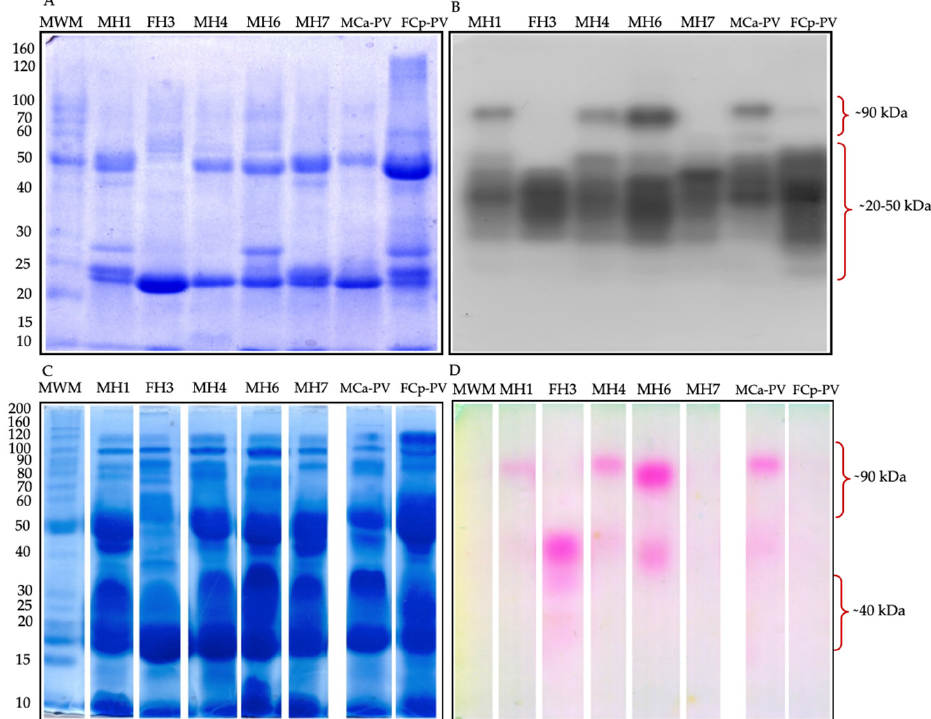
Figure 3. Venom serine protease-like zymography. ( A ) 50 µg of venom protein in a 10% SDS-PAGE gel. ( B ) Trypsin-like activity was determined using BApNA as the substrate and incubated for 2.5 h. ( C ) 100 µg of venom protein in a 10% SDS-PAGE gel. ( D ) Chymotrypsin-like proteolytic activity determined using SAAFpNA as the substrate and incubated for 2.5 h. Hybrids of the first hybridization event (11 years old): MH1, FH3, and MH4; hybrids of the second hybridization event (10 years old): MH6 and MH7; pooled venom of four male organisms of C. aquilus (MCa-PV), pooled venom of four female organisms of C. polystictus (FCp-PV). MWM, molecular weight